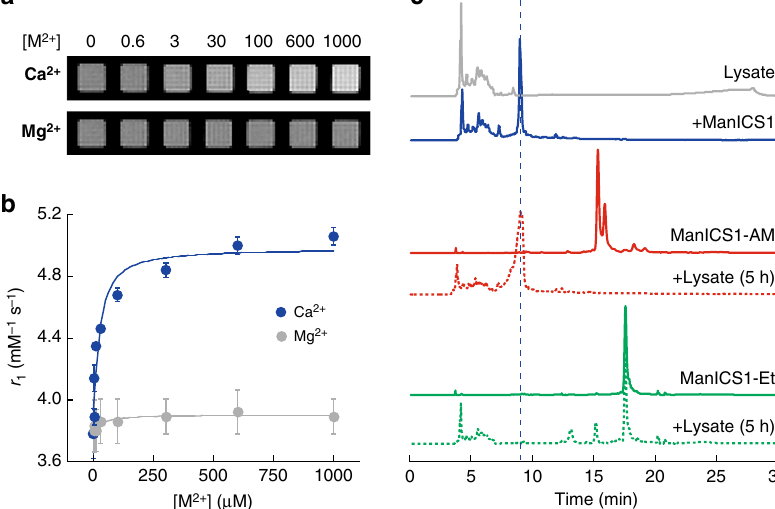
Fig. 3 ManICS1 reports calcium-dependent MRI signal changes in buffer and MnICS1-AM undergoes enzymatic hydrolysis. a T 1 -weighted images of 40 µ M ManICS1 with addition of varying micromolar concentrations of CaCl 2 (top) or MgCl 2 (bottom) in MOPS buffer, pH 7.4. b Relaxivity changes corresponding to conditions in a . Ligand-depleting bimolecular binding models were used to generate the fi tted curves shown. Error bars denote SD of four measurements. c Reversed phase HPLC traces of 10% (v/v) HEK293 cell lysate (gray), ManICS1(blue), ManICS1-AM (solid red), ManICS1-AM treated with cell lysate for 5 h (dotted red), ManICS1-Et (solid green), ManICS1-Et treated with cell lysate for 5 h (dotted green). Vertical dashed line indicates expected elution time of